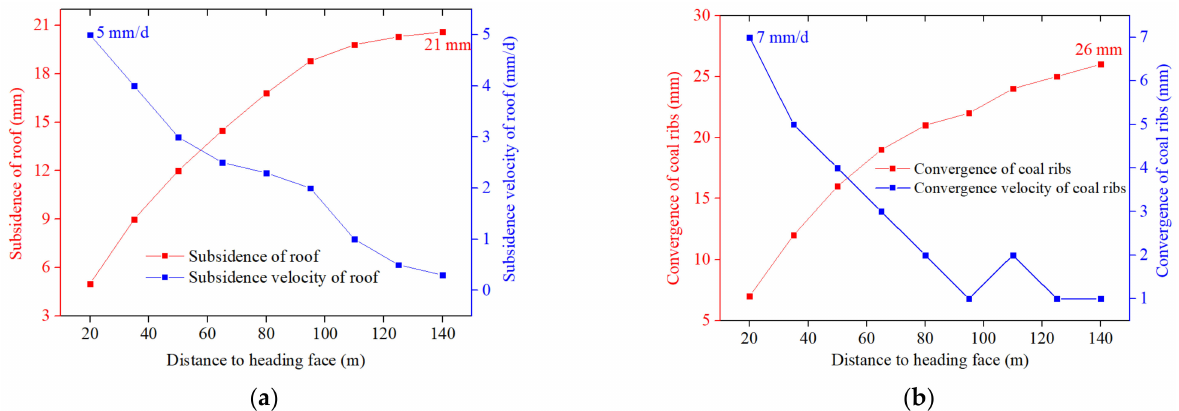
Figure 14. Monitoring of roadway surrounding rock deformation and deformation speed: ( a ) roof subsidence; ( b ) coal rib convergence.